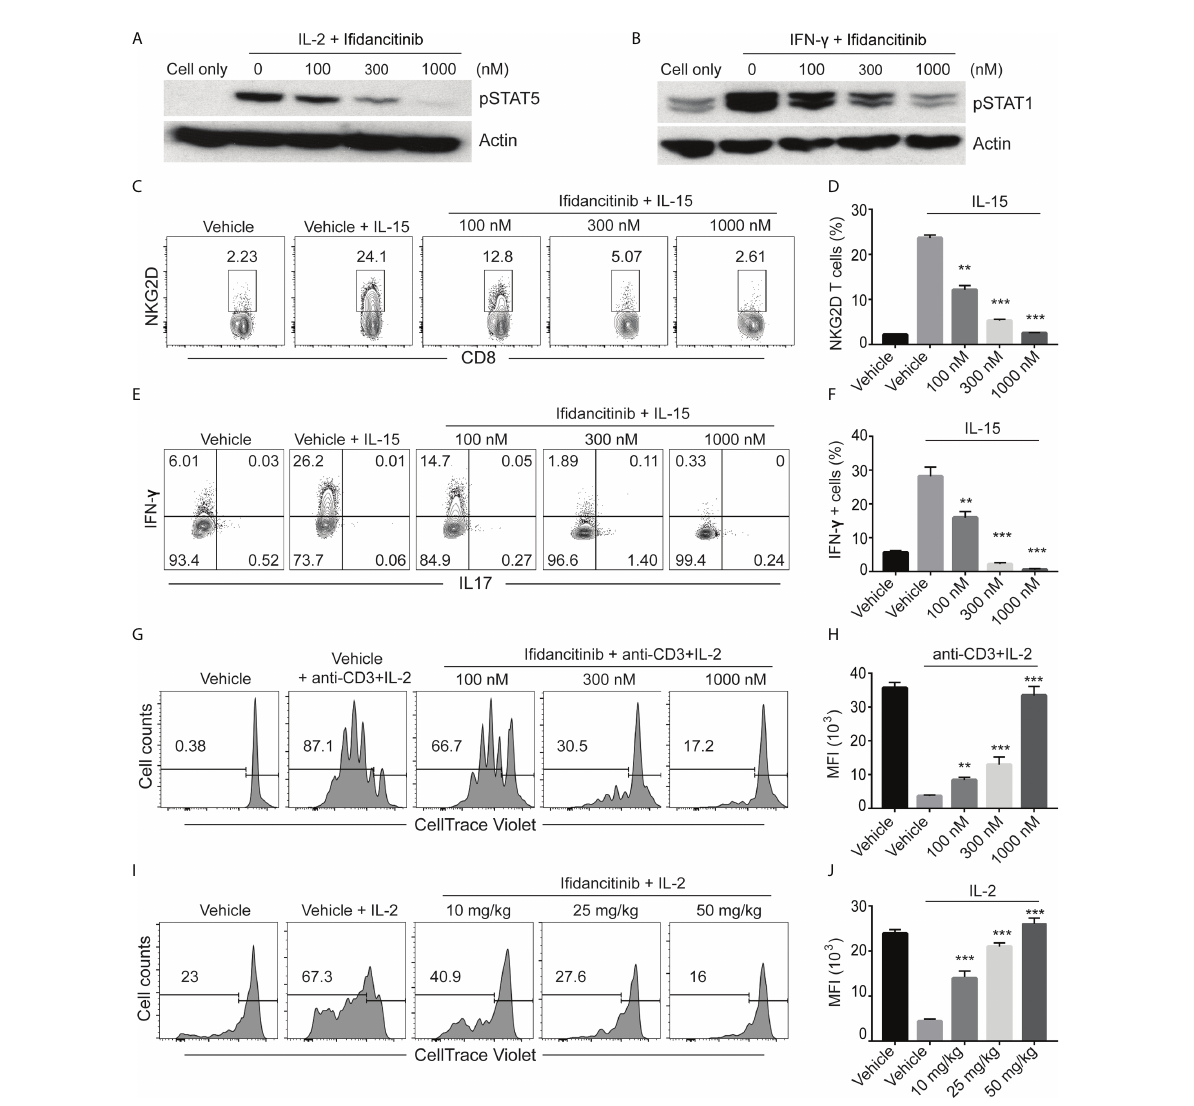
FIGURE 1 I fi dancitinib inhibited g c cytokine signaling. (A) and (B) In vitro activated T cells were pretreated with various dose of I fi dancitinib or vehicle (DMSO) for 1 h and stimulated with rhIL-2 (20 ng/ml) or rmIFN- g (40 ng/ml) for 15 min, and then cell lysates were subjected to immunoblotting with the indicated Abs. (C) to (F) CD8 T cells from normal haired C3H/HeJ mice were stimulated with rmIL-15 (50 ng/ml) in the presence of increasing dose of I fi dancitinib or DMSO for 4 (d) On day 5, NKG2D expression was analyzed by fl ow cytometry (C) and (D) . In (E) and (F) , cells were restimulated with cell stimulation cocktail in the presence of plus protein transport inhibitors and analyzed for the intracellular expression of IFN- g and IL-17. (G) and (H) CellTrace Violet labeled CD4 + or CD8 + T cells were stimulated with anti-CD3 and IL-2 in the presence of DMSO or increasing dose of I fi dancitinib for 4 (d) Proliferation of the T cells were measured by dilution of CellTrace Violet. (I) and (J) CellTrace Violet dye stained CD45.1 T cell blasts from B6 Cd45.1 were adoptively transferred to B6 CD45.2 recipients. CD45.2 recipients were then treated with I fi dancitinib and 20µg rhIL-2. Proliferation of the CD45.1 T cells were measured by dilution of CellTrace Violet. **P < 0.01, ***P < 0.001 (one- way ANOVA). The results are representative of two separate